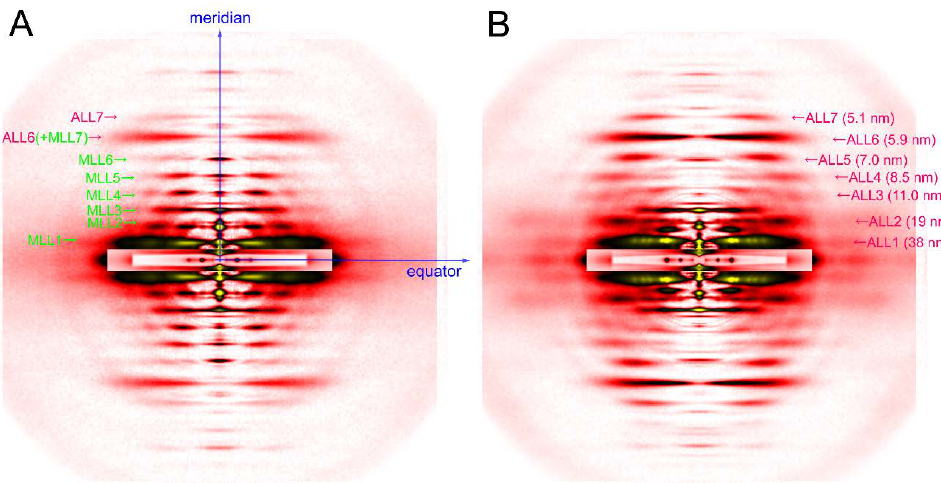
Figure 3. Diffraction pattern recorded from rabbit skeletal muscle fibers. ( A ) relaxed; ( B ) rigor. The patterns were recorded from an array of 30 skinned single fibers of psoas muscle. Note that a series of myosin layer-line reflections (MLL, green letters) in the relaxed pattern are replaced by a series of actin layer-line reflections (ALL, purple